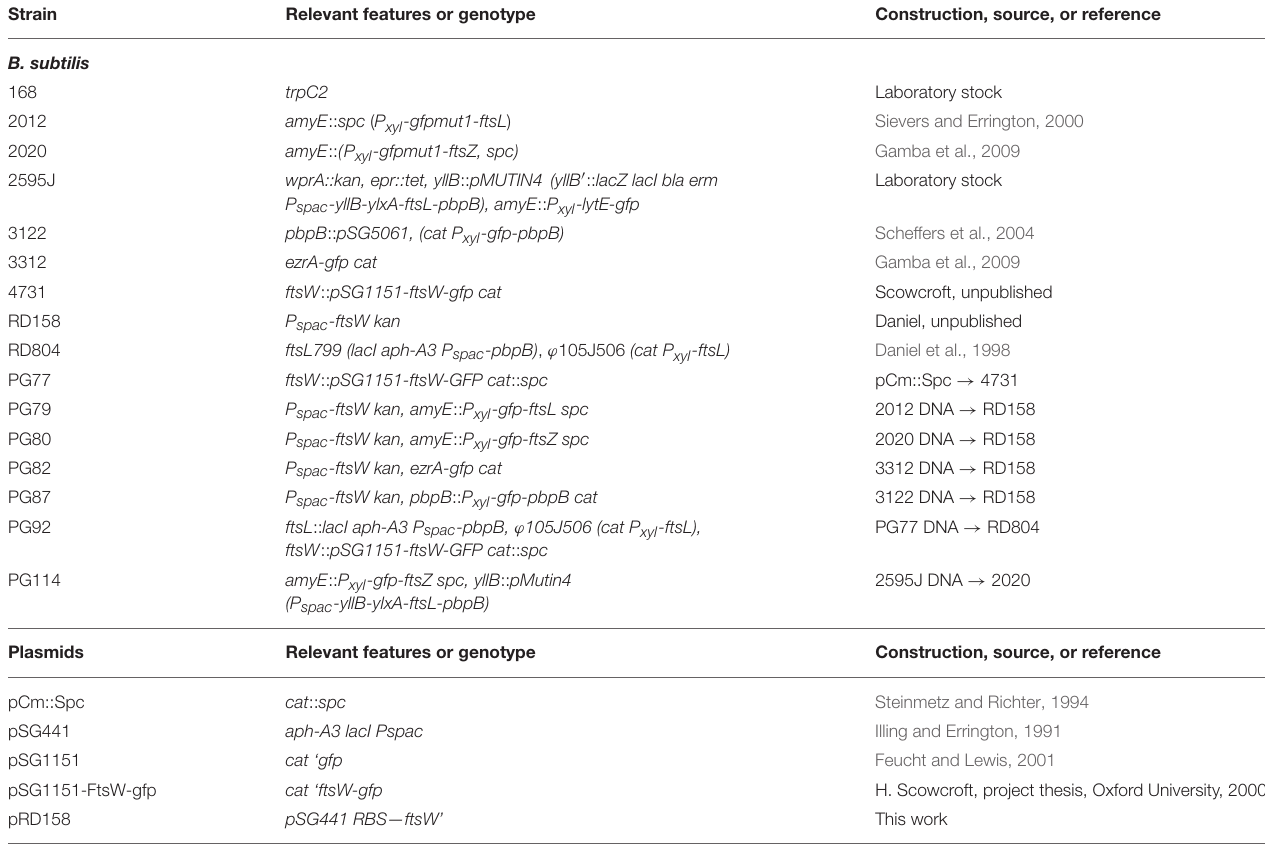
TABLE 1 | Strains and plasmids used in this study.